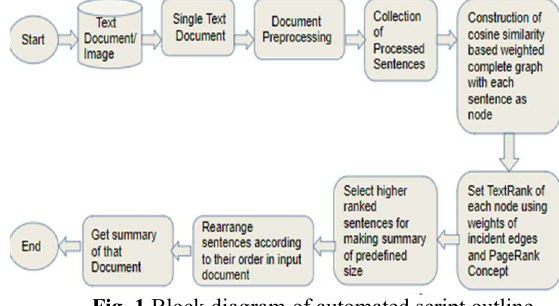
Fig. 1 Block diagram of automated script